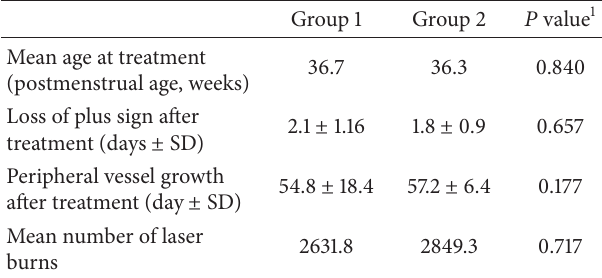
Table 2: Comparison between Group 1 and Group 2. Group 1 Group 2 𝑃 value